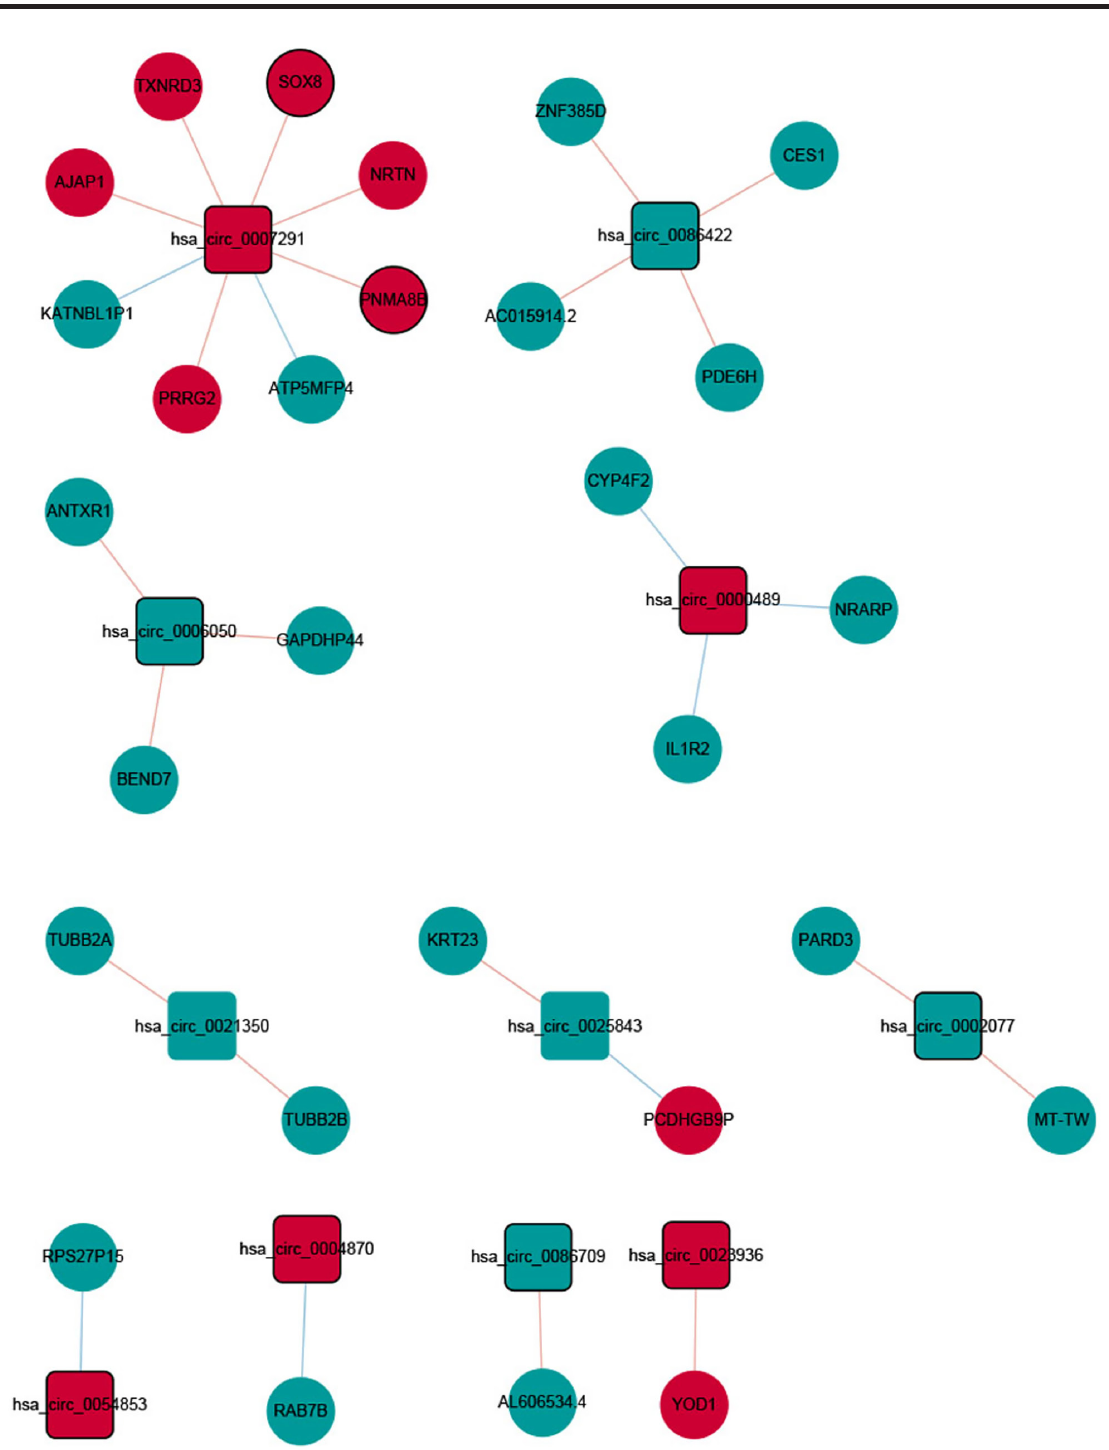
Figure 5. DEcircRNA–DEmRNA co-expression network. The rectangles and ellipses represent DEcircRNAs and DEmRNAs between recurrent group and non-recurrent group, respectively. Red and green color represent up- and downregulation, respectively. Nodes with black border were DEmRNAs/DEcircRNAs derived from top 10 up- and downregulated DEmRNAs/DElncRNAs. DEcircRNA, differentially expressed circular RNAs; DElncRNAs, differentially expressed long non-coding